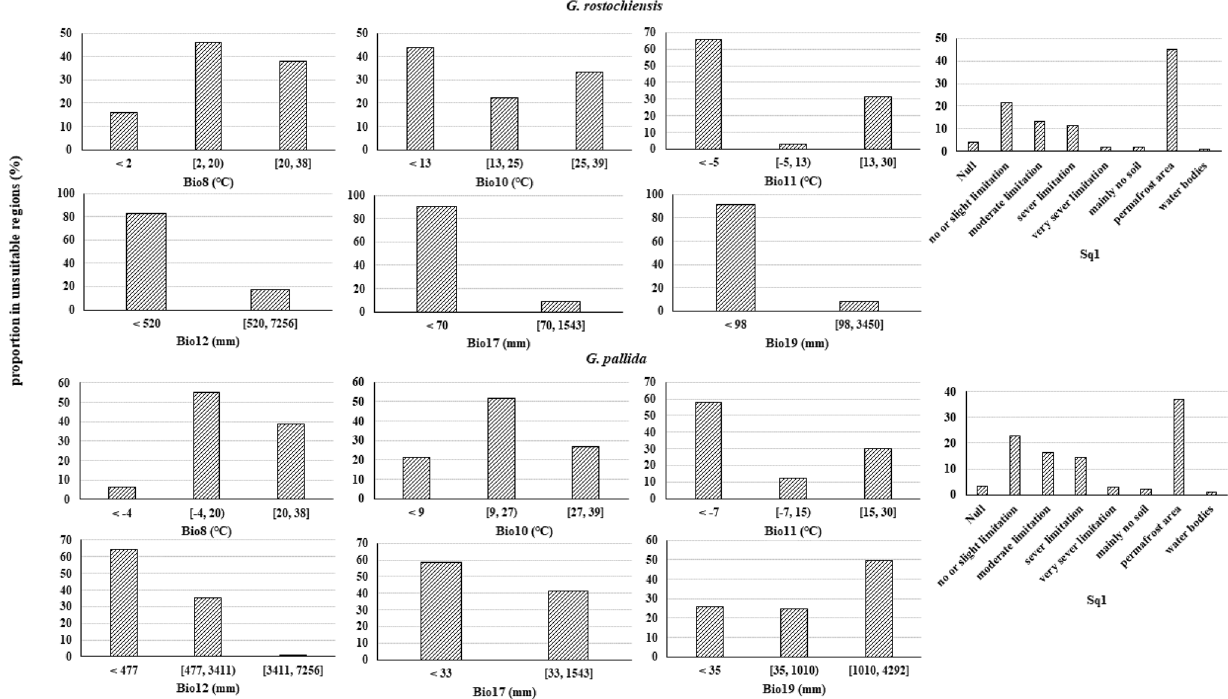
Figure 3. Histogram of environmental variables in unsuitable regions for both Globodera rostochiensis and G. pallida . Bio8 average temperature of the wettest quarter, Bio10 average temperature of the warmest quarter, Bio11 average temperature of the coldest quarter, Bio12 annual precipitation, Bio17 precipitation of driest quarter, Bio19 precipitation of coldest quarter, Sq1 soil quality (integrated soil texture, soil organic carbon, soil pH, total exchangeable